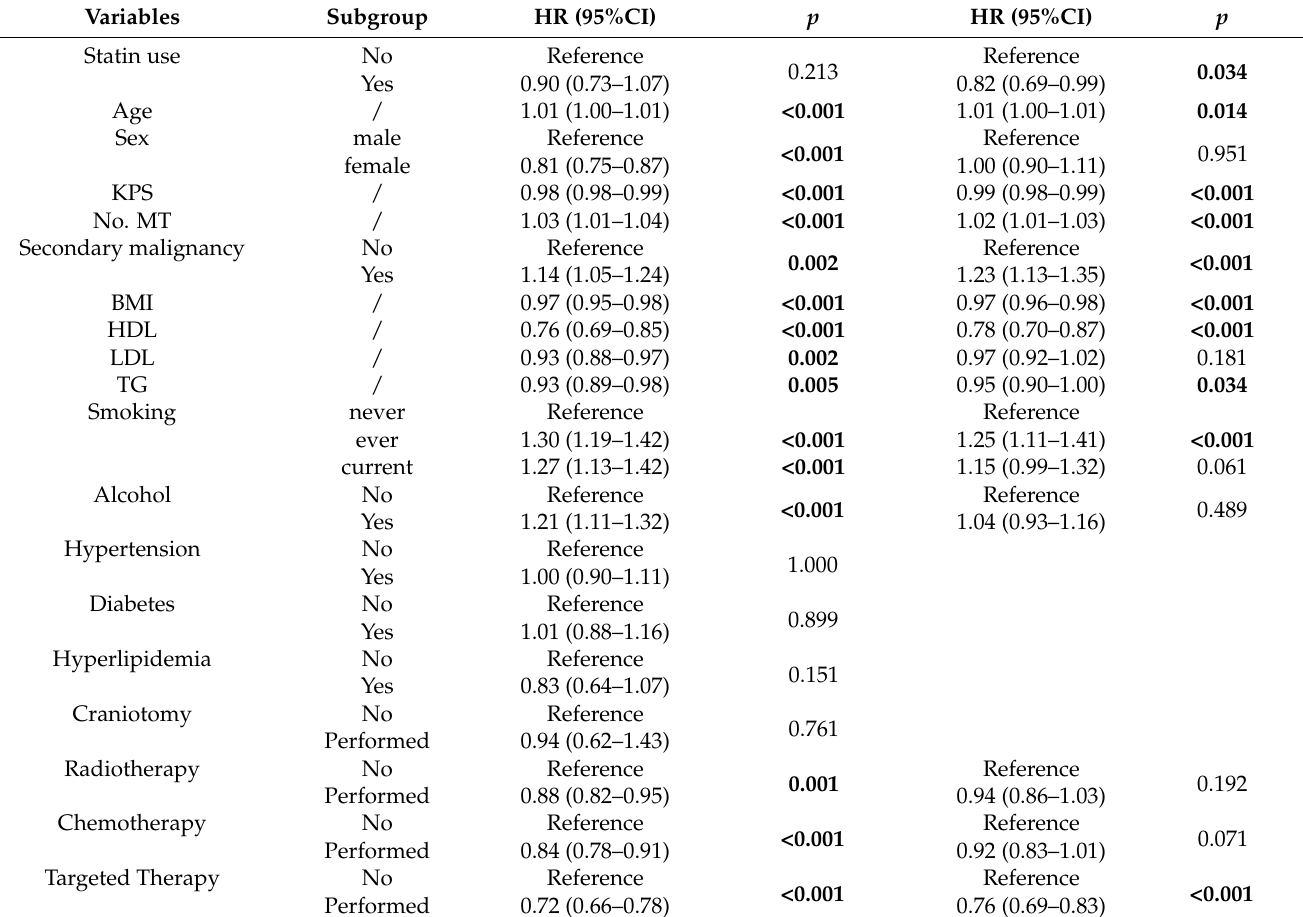
Table 2. The univariate and multivariate Cox analyses of the statin use and overall survival of brain metastatic